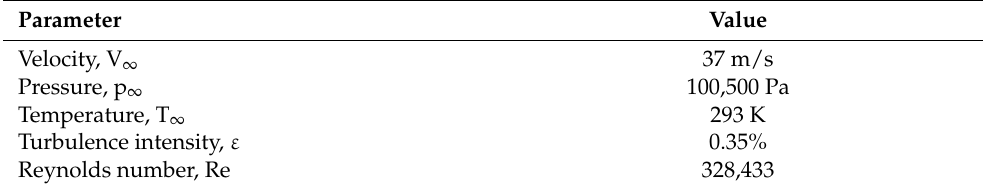
Table 1. Experimental conditions in MAI T-1 wind